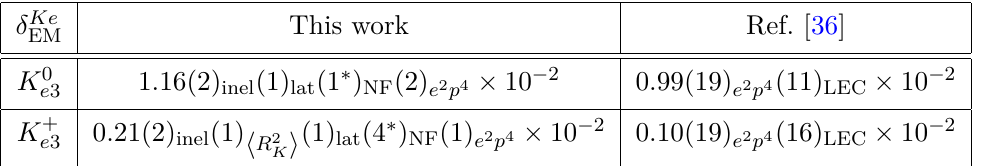
obtained from this work and from the ChPT EM